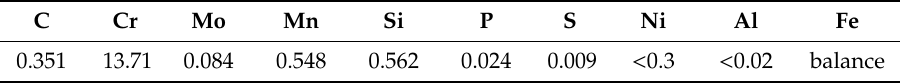
Table 18. Chemical composition (%weight) of AISI 420 martensitic stainless steel [121]. C Cr